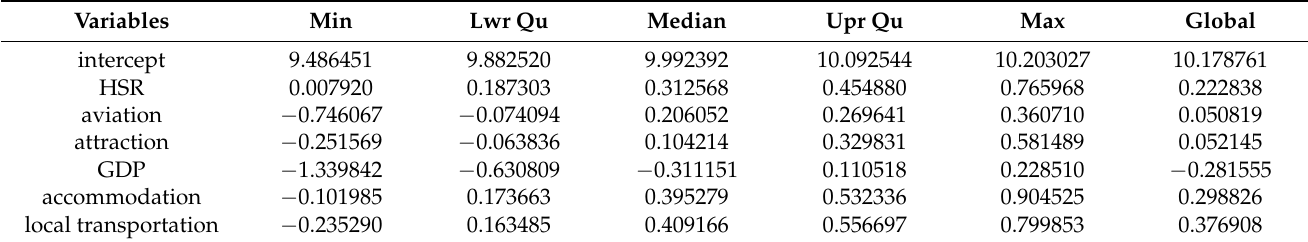
Table A2. GWPR Results for the year 2015.